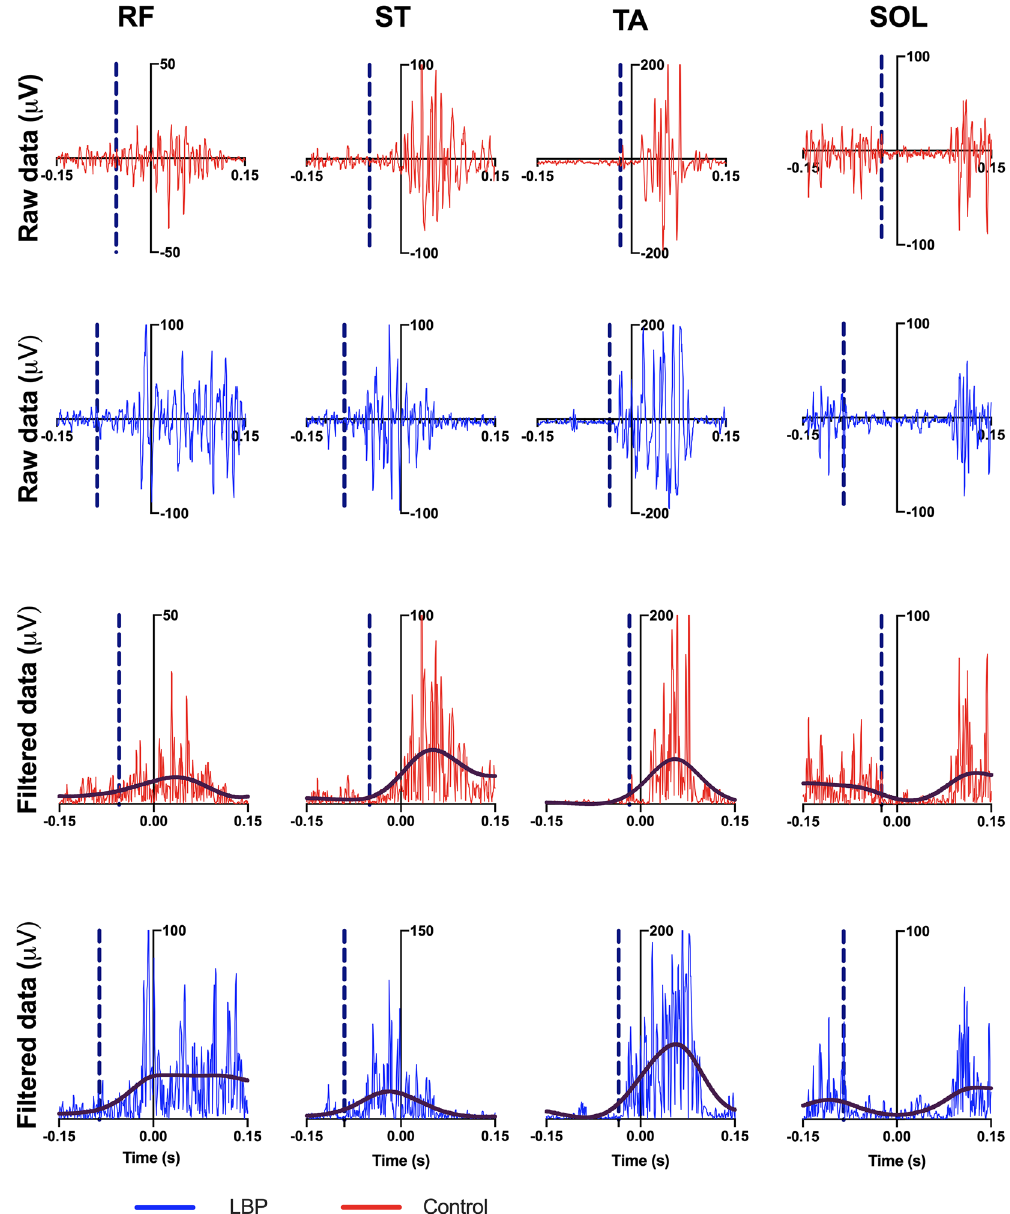
Figure 4. Raw and rectified 6 Hz low-pass filtered muscles activity of a typical participant of each group, recorded during one single trial. Vertical blue dashed line indicates muscles onset (t 0 ). Muscle abbreviations: ST semitendinosus, RF rectus femoris, SOL soleous, TA tibialis anterior. Control participants’ anticipation compared with CLBP